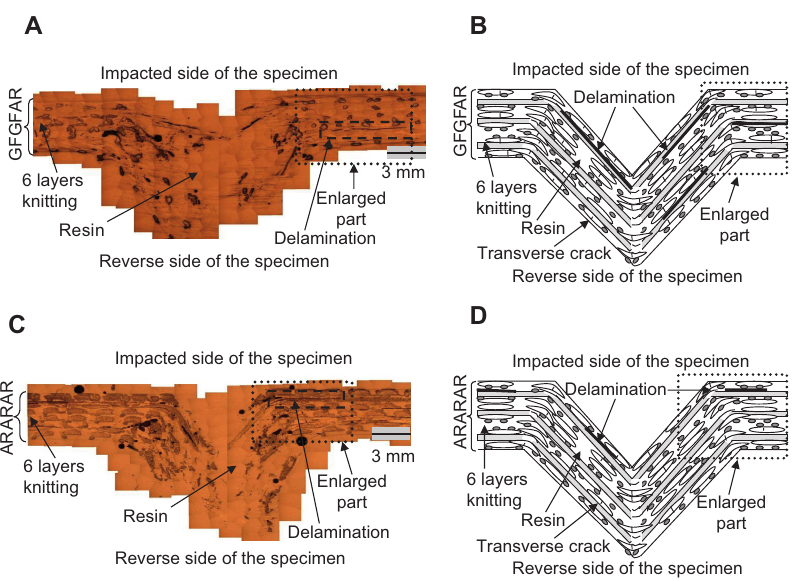
Figure 11A–D shows the enlarged parts and sche- matic drawings of Figure 10A–D. In the GF-GF-AR specimen, the long delaminations occurred near the impacted side and reverse side of the specimens. In contrast to the GF-GF-AR specimen, the long delamina- tions occurred only near the impacted surface of the